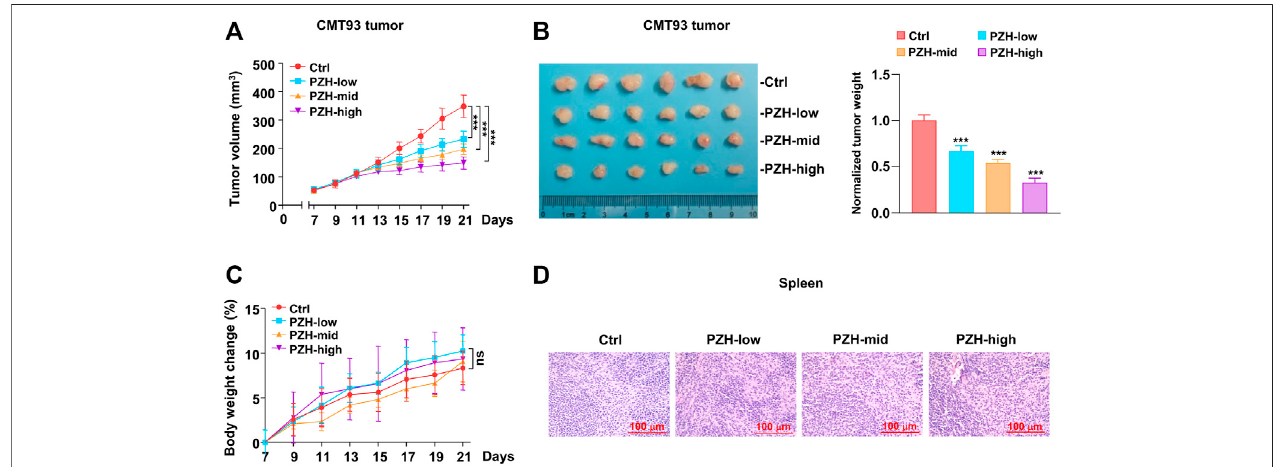
FIGURE 2 | PZH stalled the CMT93 xenograft tumor growth in vivo . (A – B) The growth (A) , size and weight (B) of CMT93 xenograft tumor were attenuated in PZH treated mice compared with Ctrl group at day 21 of treatment ( n = 6 per group): control and indicated dose of PZH (low: 0.078 g/kg; medium: 0.234 g/kg; high: 0.672 g/kg). Tumor weights were normalized with the mean value of Ctrl group. (C) PZH had no signi fi cant effect on the body weight of mice ( n = 6 per group). (D) PZH had no obvious damage to the spleen of mice. The results are representative of one of three experiments. Data are presented as means ± SD, ns p > 0.05, *** p < 0.001 based on one-way